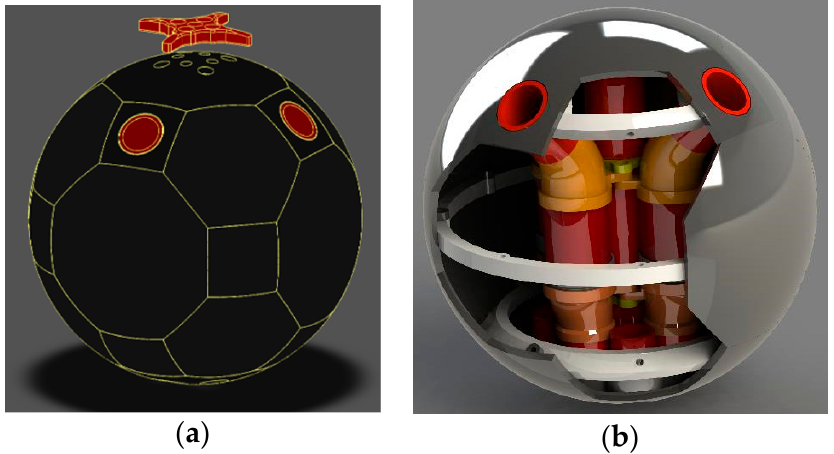
propulsion system was designed to implement a 4-DOF navigation strategy. To achieve maximum sensor coverage while minimizing maneuvers, and their associated risk of entanglement or sediment disturbance, a plated, spherical hull was developed, as shown in Figure 3 to enable the placement of multiple cameras.